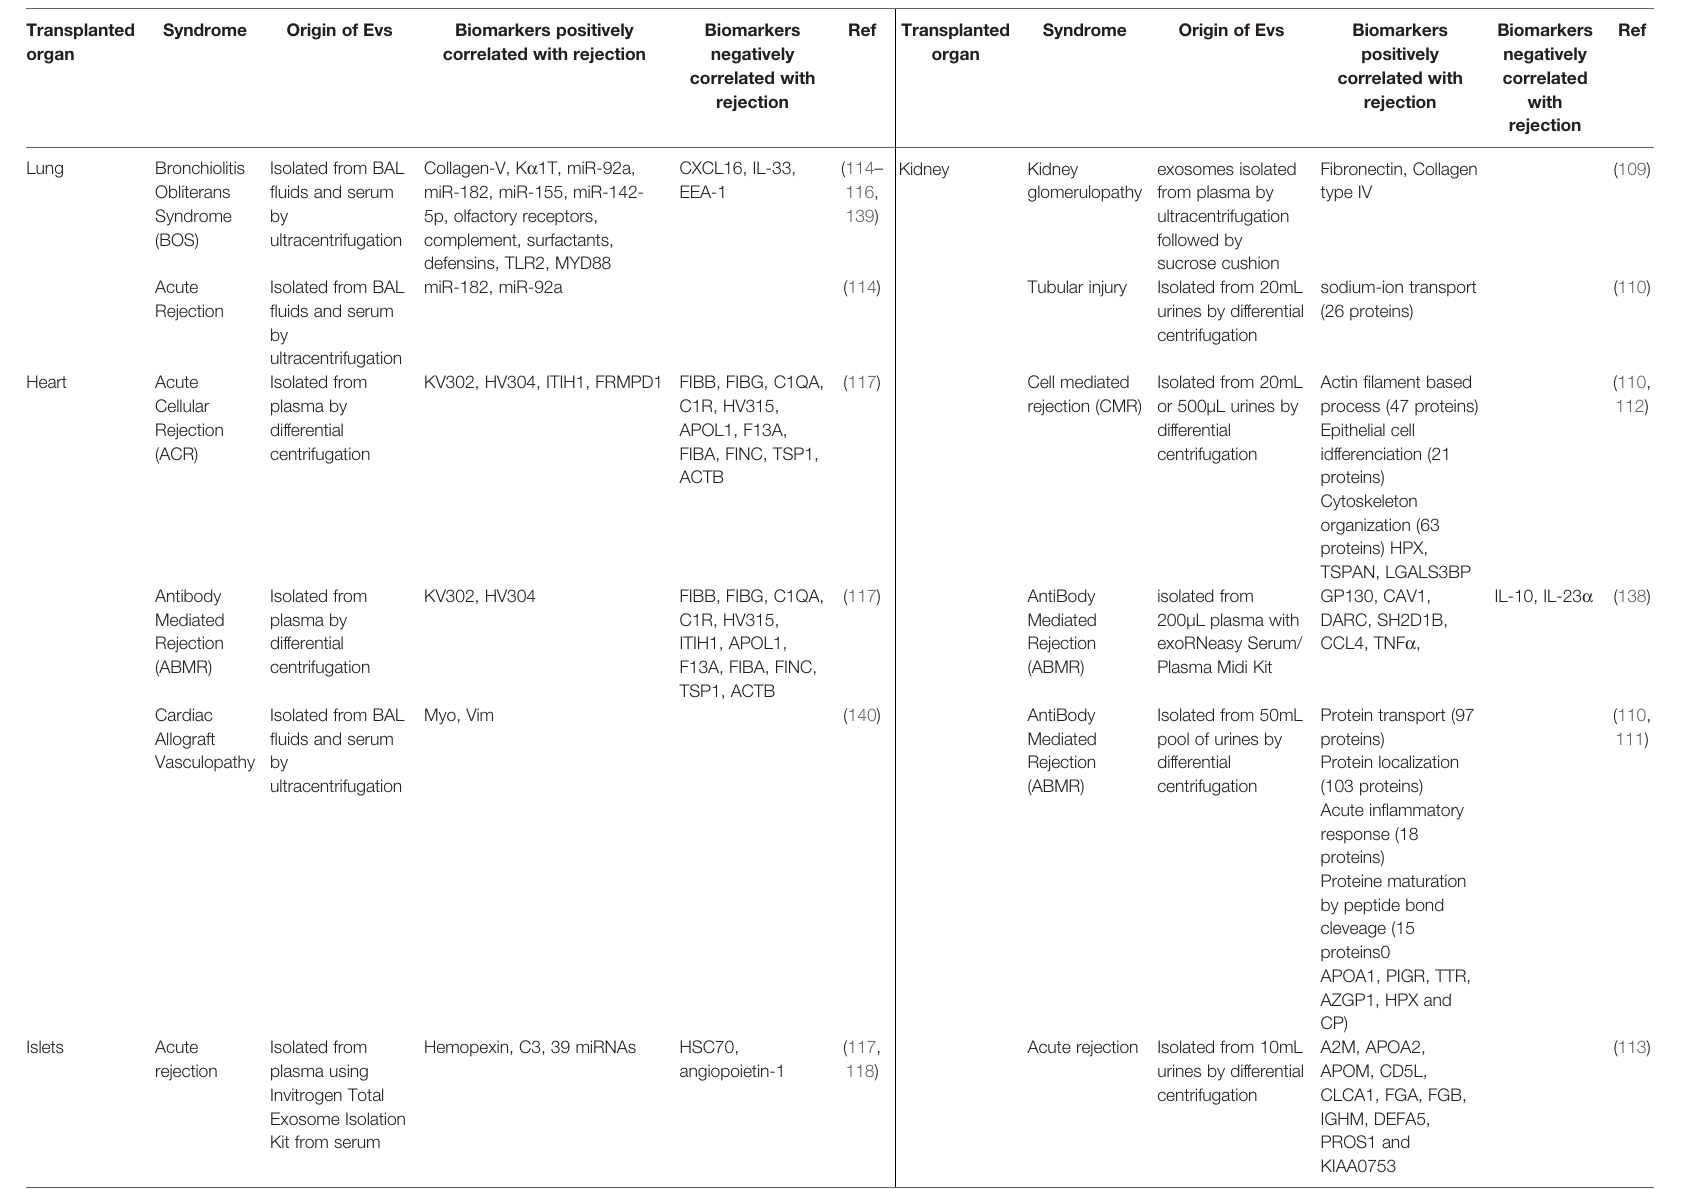
TABLE 1 | Markers of graft rejection in the EV